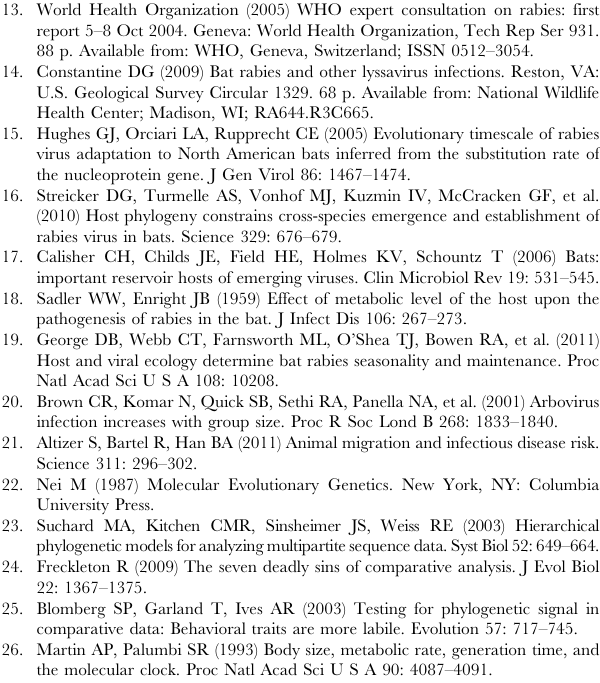
Table S5 Phylogenetic generalized least squares regression support for the confidence set of models found in the generalized